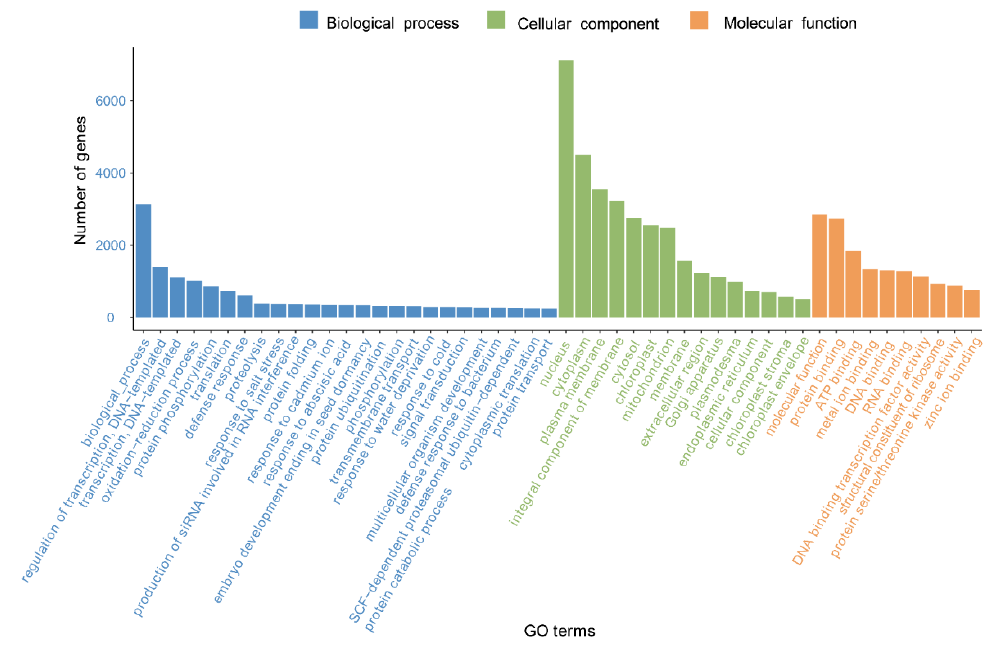
Figure 2. GO classification of G. macrophylla transcriptomic unigenes.